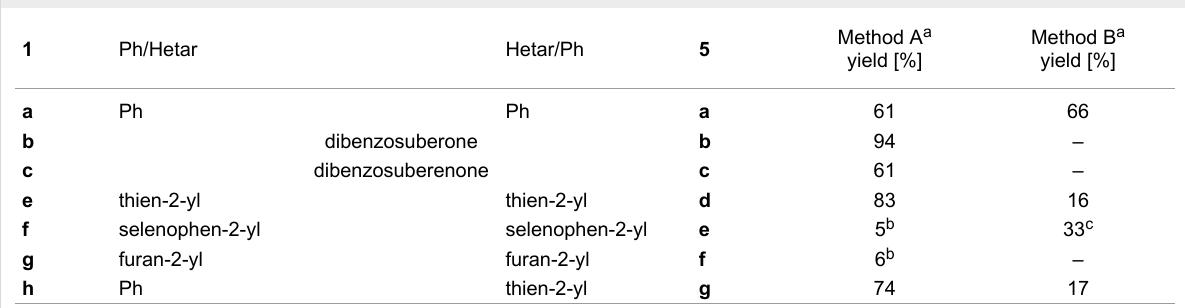
Table 1: Fused 2H -thiopyrans 5